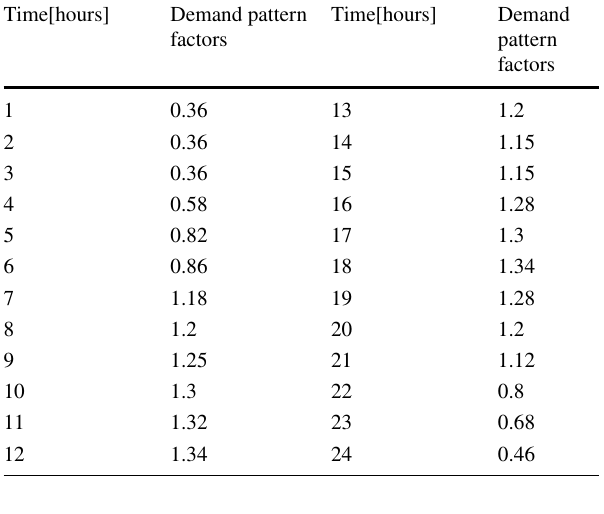
Table 5 Daily water demand pattern factors